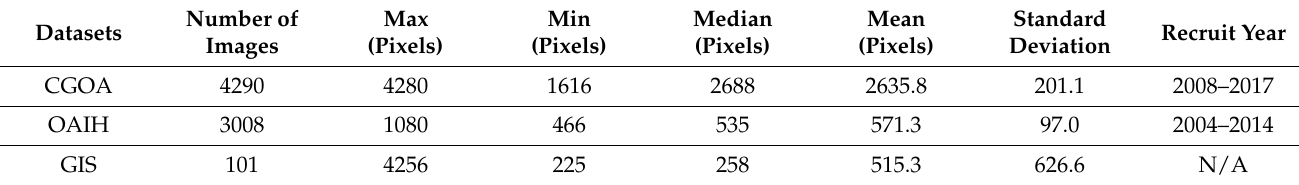
Table 1. Summary statistics of the three datasets used in this